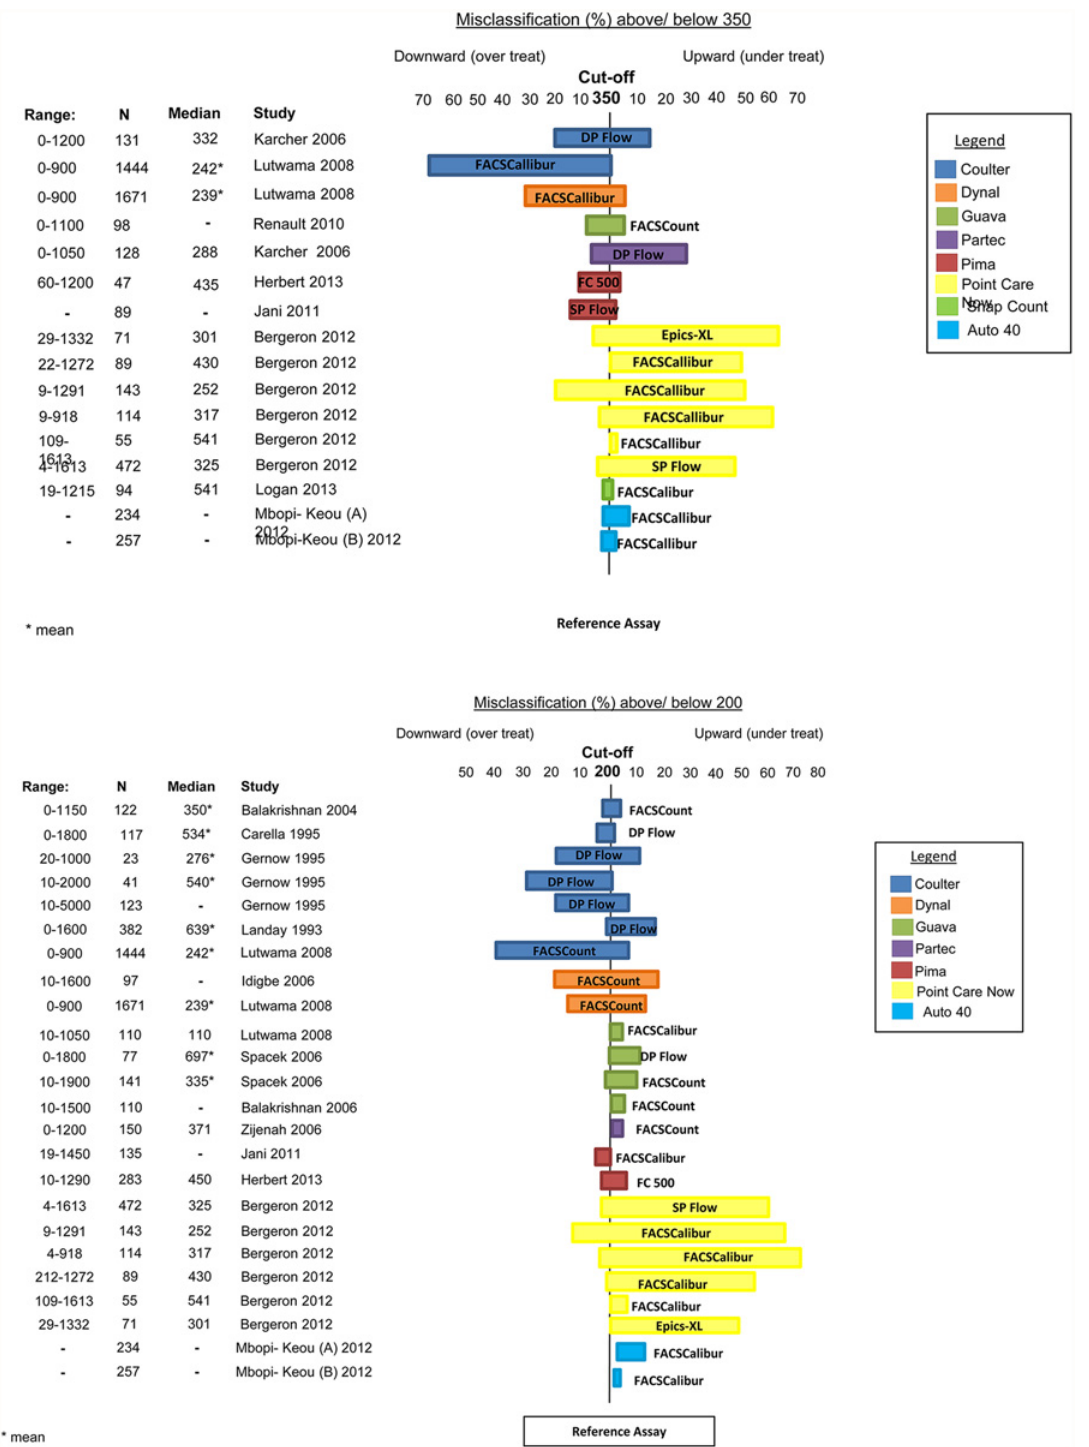
Fig 4. Misclassification (%), using a CD4 thresholds of 350 cells/ μ l and 200 cells/ μ l.